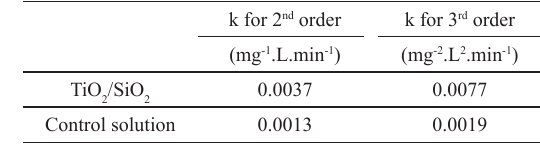
Table 4. Velocity rate constant (k), for TiO for the first 360 minutes of reaction.